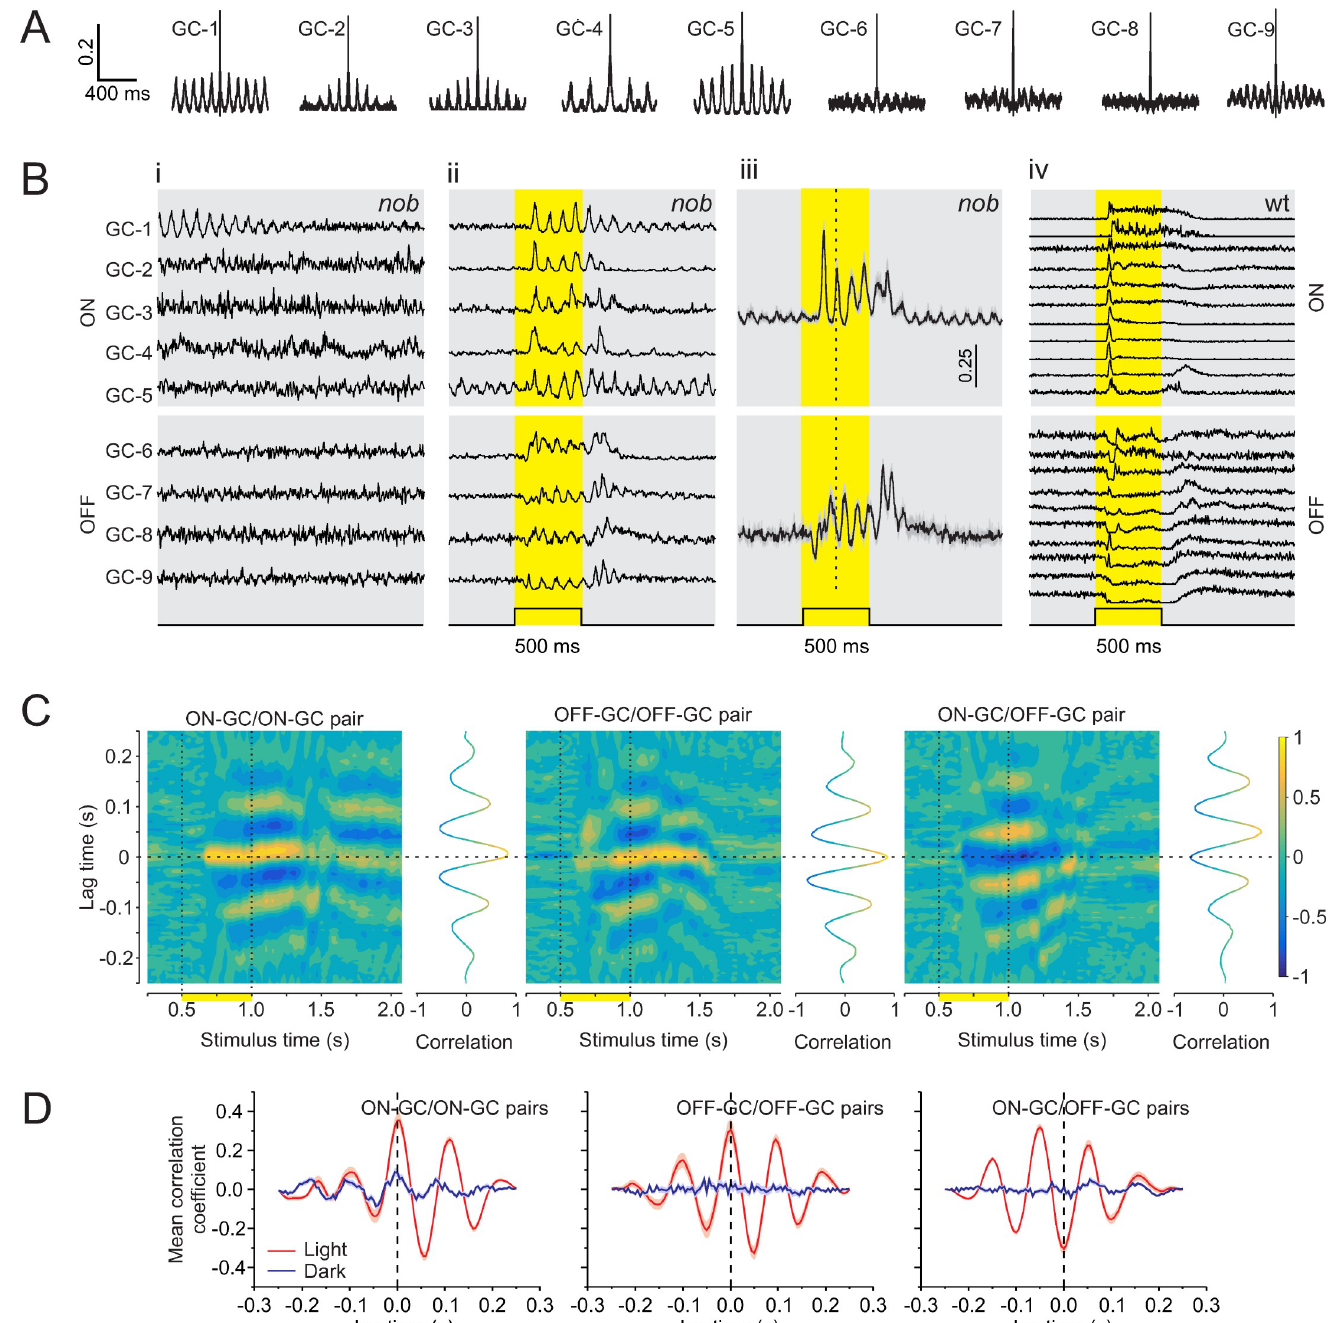
Fig 3. In the dark, nob mice GCs oscillate asynchronously, but light stimulation synchronizes their oscillations. Results based on GC spiking responses recorded on an MEA. (A) Autocorrelations of 9 representative nob GCs from one retina in the dark. Periodic variations in their autocorrelations indicate spontaneous oscillatory activity. (Bi) Each trace shows the mean normalized GC activity of 100 episodes of activity in the dark during the first 2 s of a 5-s window. All episodes were aligned to the first spike in the corresponding episode of GC-1 and then averaged. A clear oscillatory pattern is initially apparent for GC-1. In contrast, none of the other cells showed a similar pattern, suggesting that each nob GC oscillated with a frequency and/or phase, independent of GC-1. (Bii) Mean normalized activity of the same nob GCs in response to a 500-ms light flash (yellow shading). Note the presence of oscillation in all GCs, indicating that their phase was reset by the light flash. (Biii) Mean ( ± SEM) light-evoked oscillations of GCs could be separated into two clusters that oscillated in antiphase with each other. One cluster showed a decrease in spike rate just after light onset identifying them as OFF-GCs (bottom; n = 10), whereas the other cluster responded with a delay and in antiphase, suggesting they were ON-GCs (top; n = 13). (Biv) Mean responses of 21 wt GCs to the same stimulus used in (Bii-iii) show no oscillatory activity evoked by the light flash. (C) Short-time cross-correlations between mean responses of representative nob ON-GC/ON-GC, OFF-GC/OFF-GC, and ON-GC/OFF-GC pairs during the